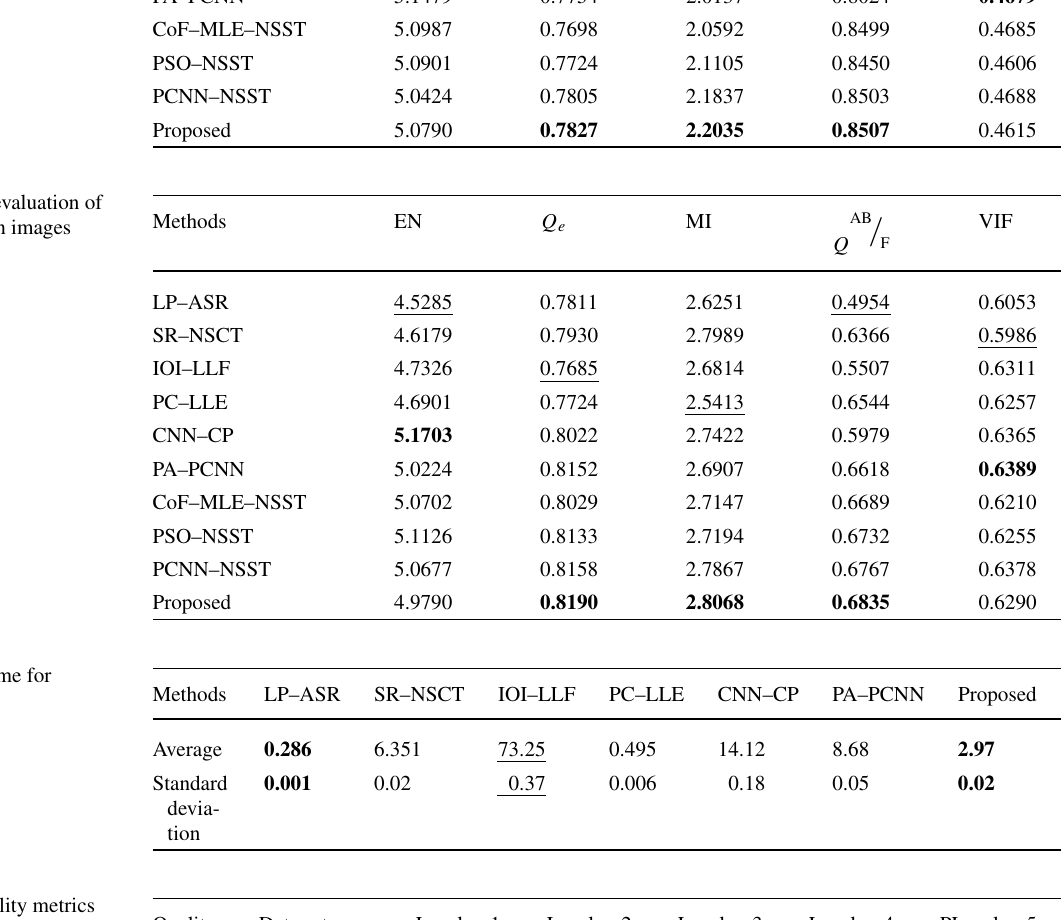
Table 4 Fusion quality metrics analysis based on different levels and